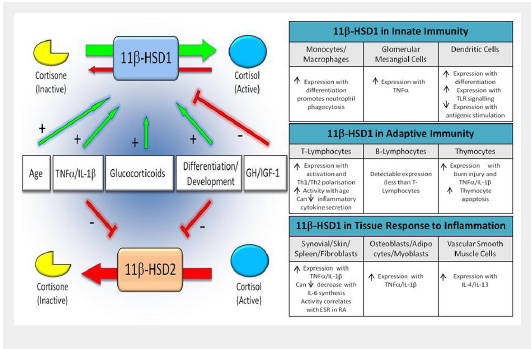
Overview of the cortisol activating enzyme 11β-HSD1, and the cortisol inactivating enzyme 11β-HSD2 and their regulation within different leukocyte